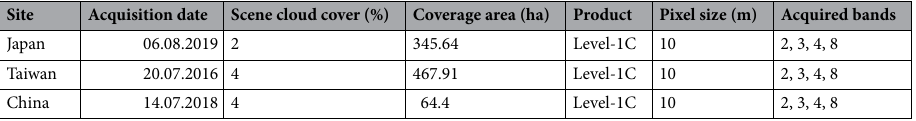
Table 1. Details of images acquired for each